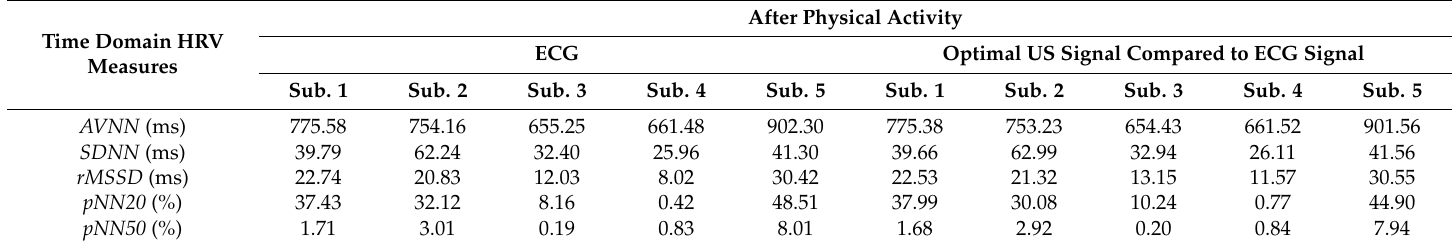
Table 5. Representative time domain values of HRV measurements in a 5 min data set, after 1 min physical activity, subject 1–5, part 1.